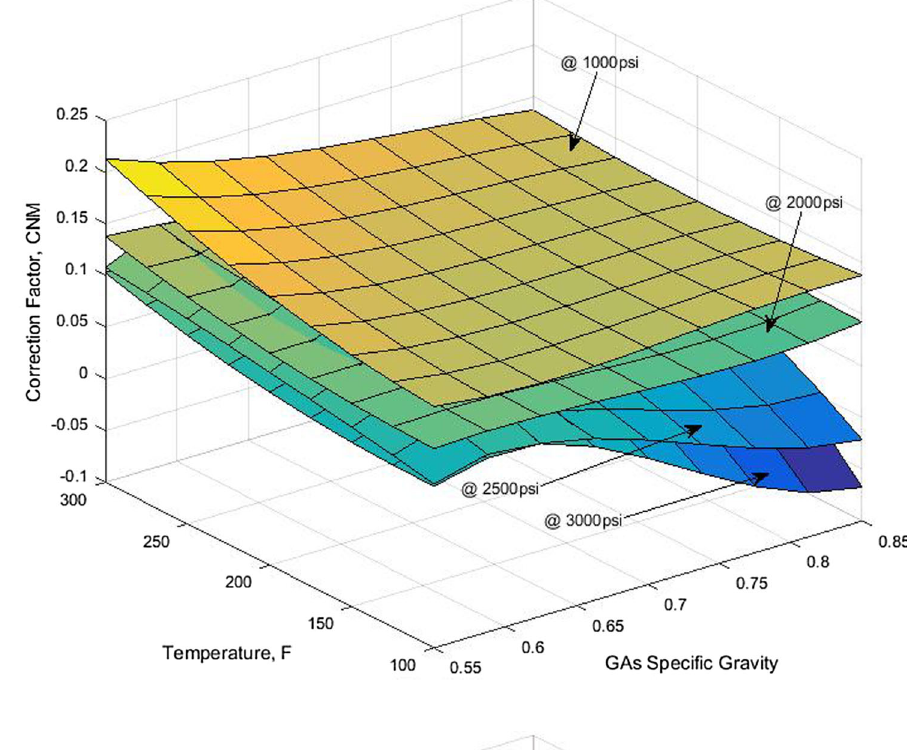
Fig. 14 Isobar plot for natural gases in Table 1 at 5000